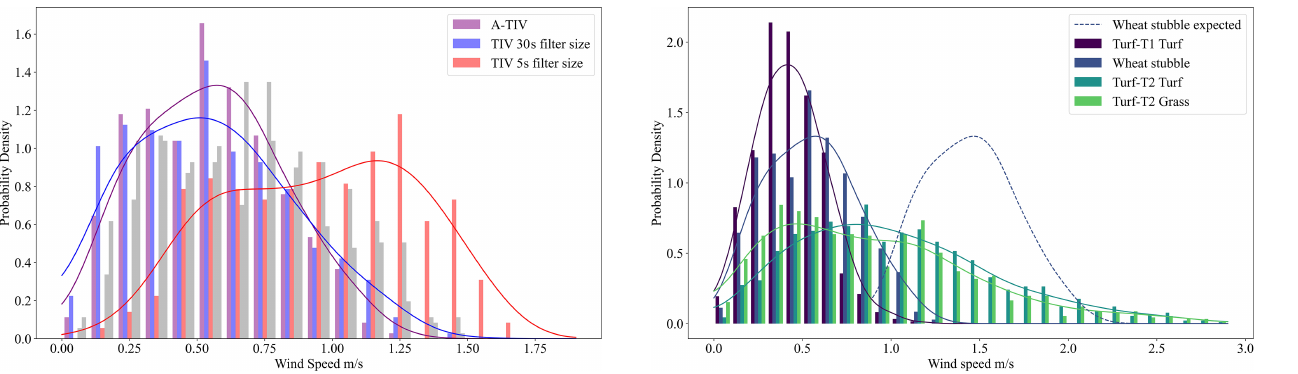
Figure 13. A-TIV comparison of all experiments – probability den- sity functions for the ∼ 15m × 15m average aerial wind speed from all experiments. It is evident that the wheat stubble experi- ment shows the lowest average wind speed histogram distribution whereas the mean wind speed was the highest during the experi- ment. The dashed line shows the expected probability density based on the ratio 6 : 1 calculated in Table 3. The decrease demonstrates the effect of the